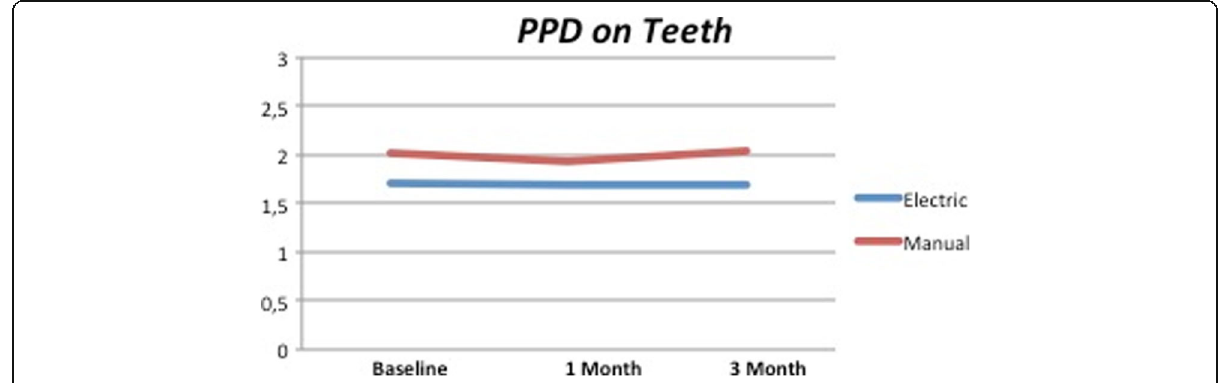
Fig. 8 PPD on natural teeth. No significant differences